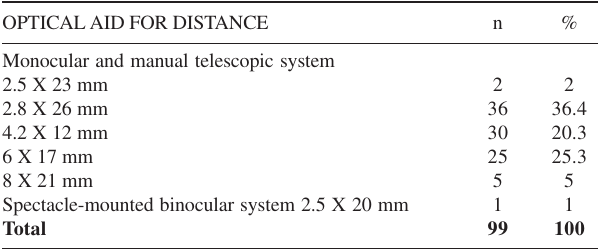
Table 4 - Distribution of frequency of prescribed optical aids For far distance in the pediatric population with low